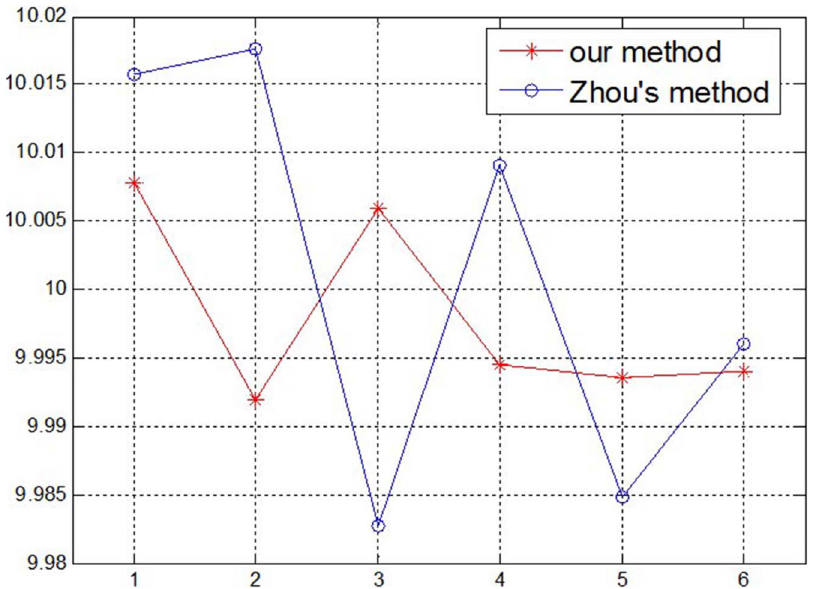
Figure 18. The measurement results of 10 mm Gauge block.